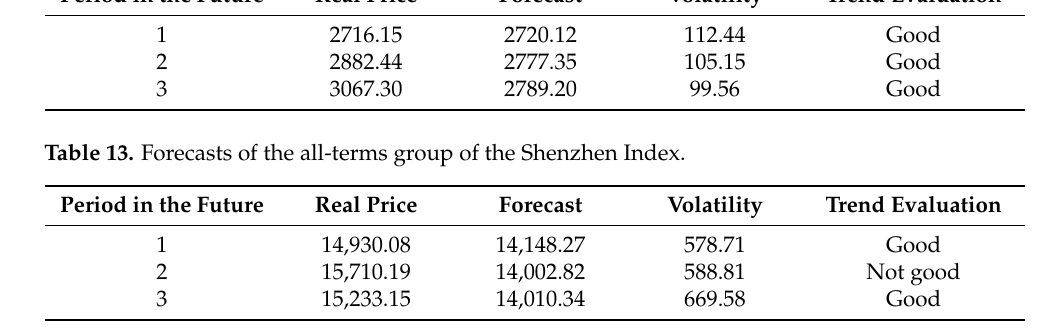
Figure 13. Comparisons between the forecast and real price in five periods in the future of the Shanghai Index (all-terms group). Table 12. Forecasts of the all-terms group of the Second Board Index.